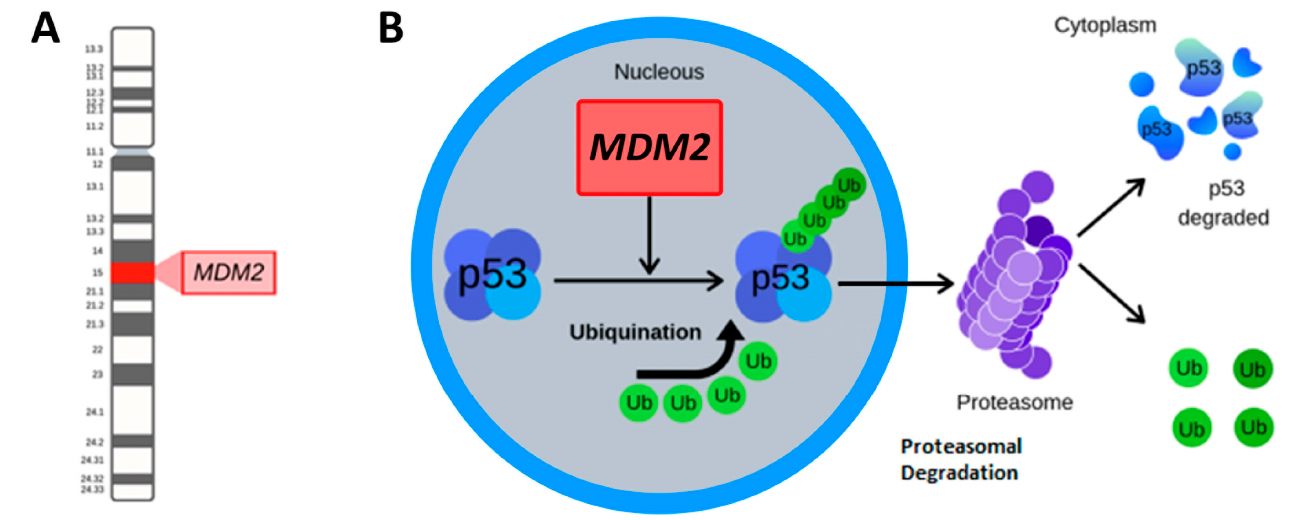
Figure 1. MDM2 location and function. ( A ) MDM2 is located in the long arm of chromosome 12, region 1, and band 5 (12q15). ( B ) MDM2 is an E3 ubiquitin ligase that targets p53 for ubiquitylation and subsequent proteasomal degradation.